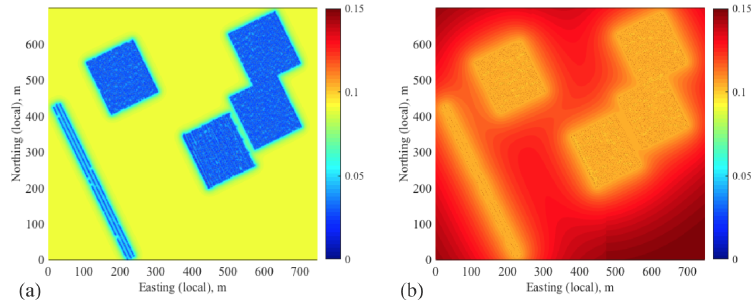
Figure 8. The estimated standard deviation of snow depth across the site (in meters) based on (a) the proposed Bayesian method, including the correlation to microtopography, and (b) the kriging-based interpolation of the snow surface. The spatial extent is the same as Fig. 1b.